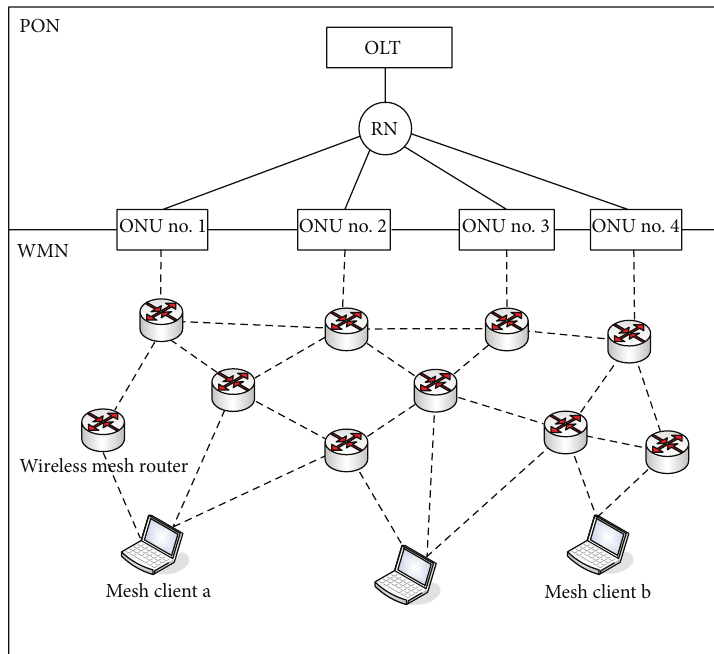
Figure 1: Typical architecture of a Fi-Wi Network.